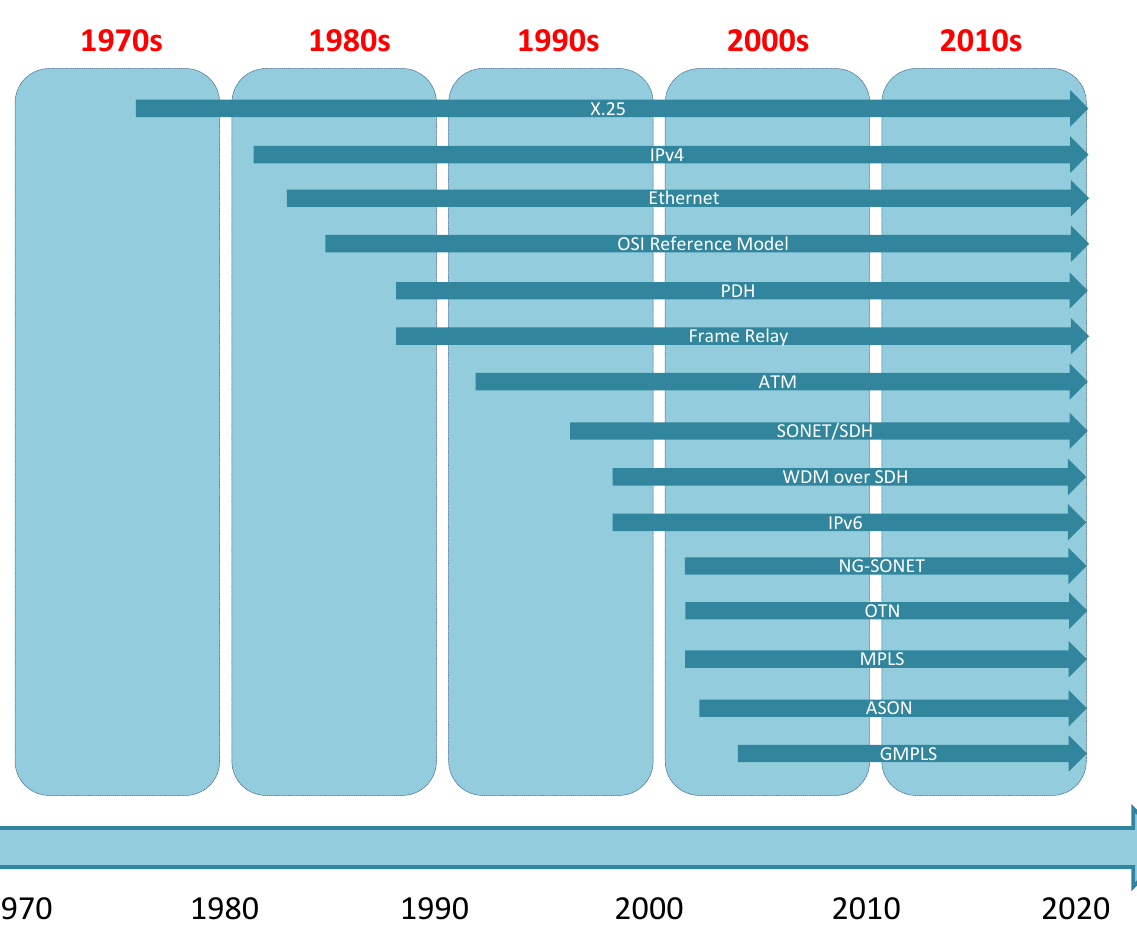
Figure 22. The evolution of backbone (metro/core) transport network standards.